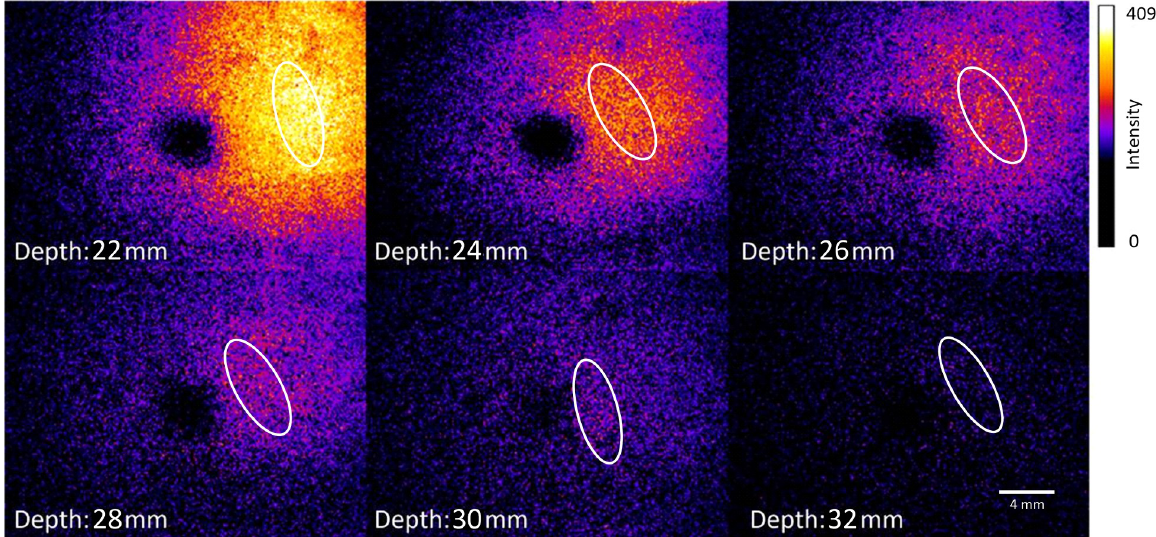
Fig 3. Depiction of the results obtained for ICG-labeled tumor phantoms measured in animal